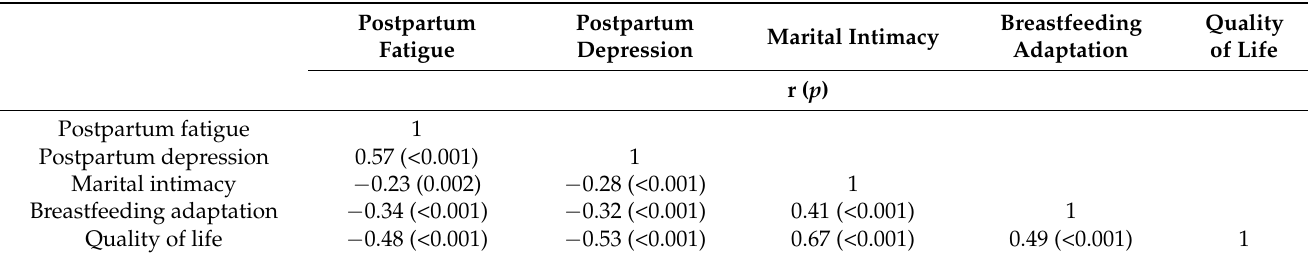
Table 4. Correlations between Variables.